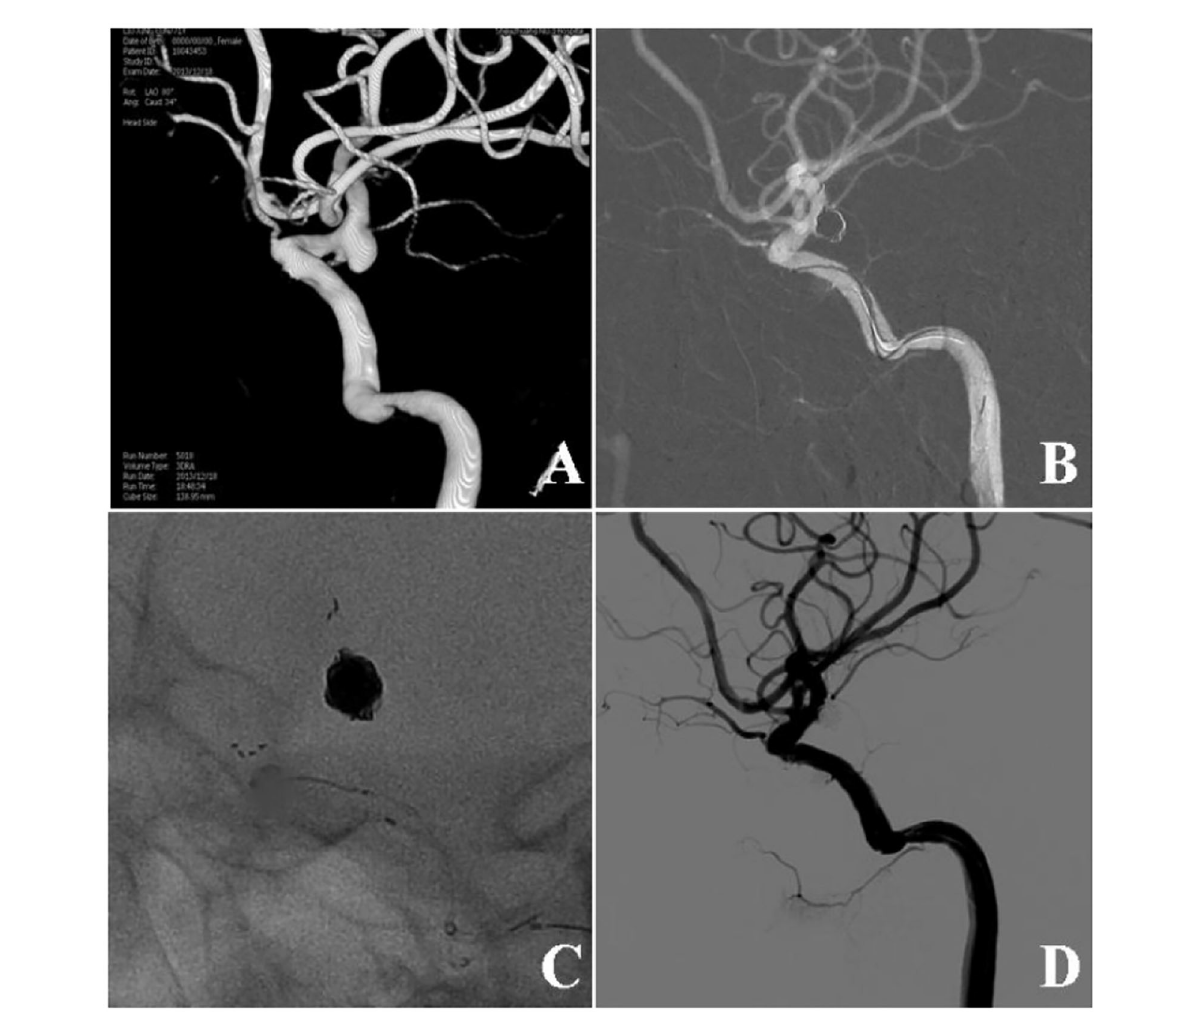
FIGURE1 Stent-assisted coiling of a wide-necked ruptured aneurysm at the posterior communicating artery (Pcom). (A) Three-dimensional digital subtraction angiography showed a wide-necked aneurysm at the Pcom. (B) An Enterprise stent was used for assisting aneurysm coiling. (C) The stent and the coil mass are shown. (D) Six months following embolization, the aneurysm remained totally